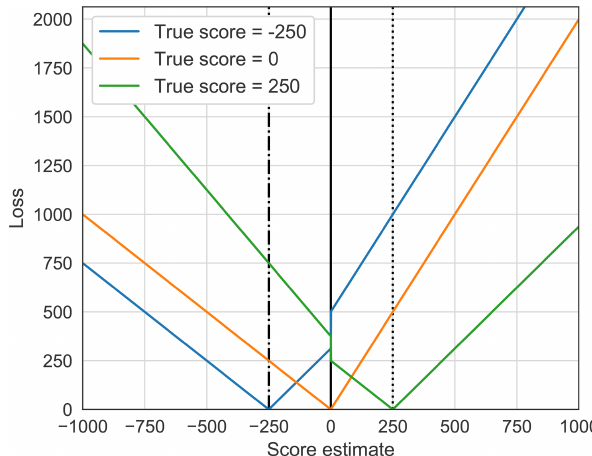
Figure 2. Loss based on the risk-neutral custom loss function (Eq. 8) for determined true scores of − 250, 0, and 250. This plot is meant to clarify the way real losses are incurred for each esti- mate relative to a given true value. The expected loss, as seen in Fig. 1, is acquired by arithmetically averaging over all deterministic loss realizations based on the score probability distribution by using Eq. (3).